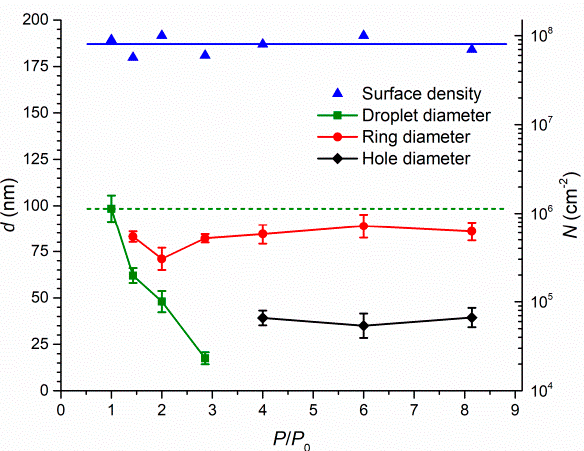
Figure 4. Pressure ratio dependences of the average size and surface density of droplets obtained after the deposition of 1.5 ML of indium and further exposure to ultra-low arsenic flux. The caps represent standard deviations of the diameter of nanostructures.